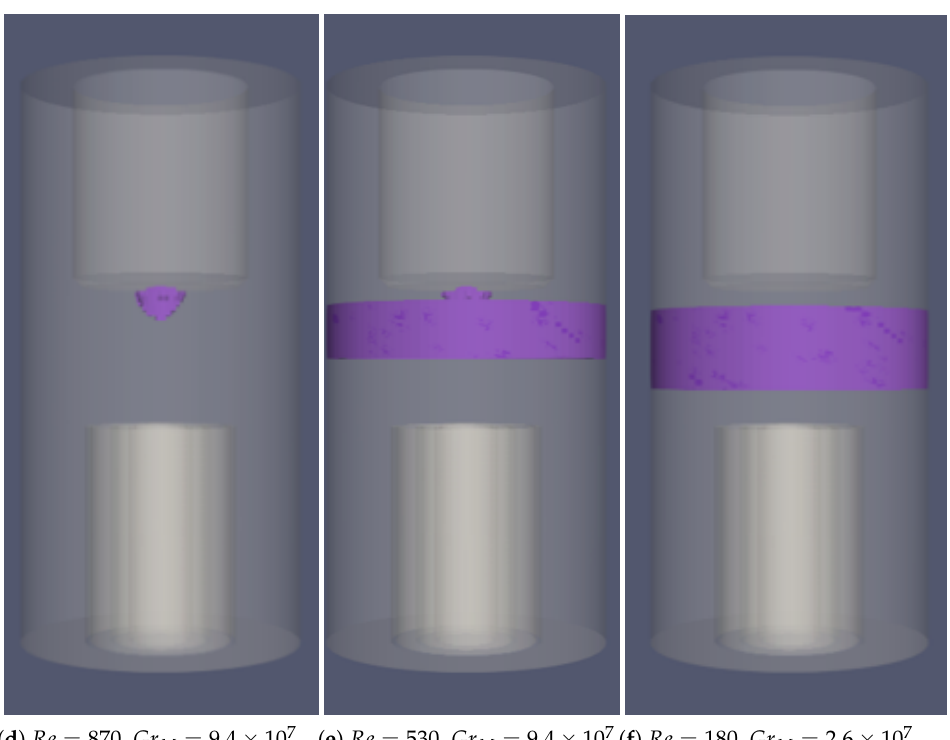
Figure 4. Location of instabilities in the down-flow reactor ( a – c ) and up-flow reactor ( d – f ) for varying NH 3 in the